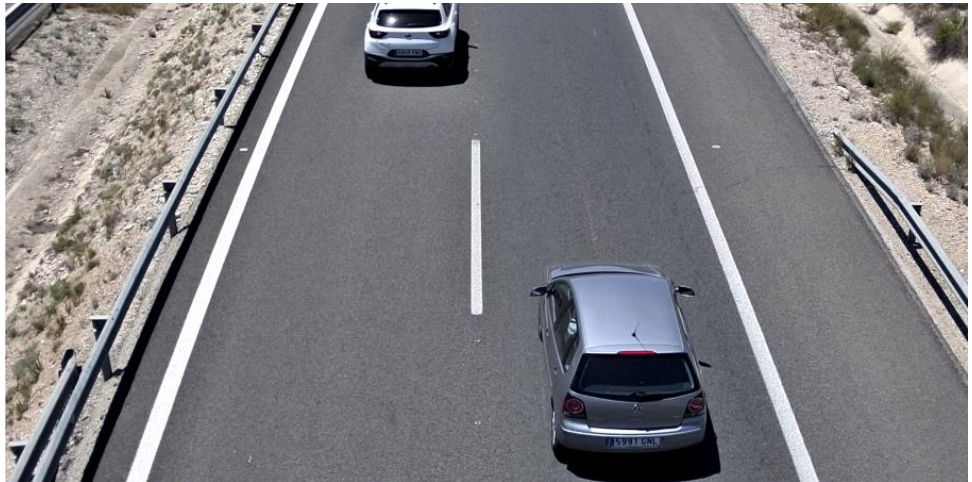
Figure 12. Highway Gantry Dataset sample.